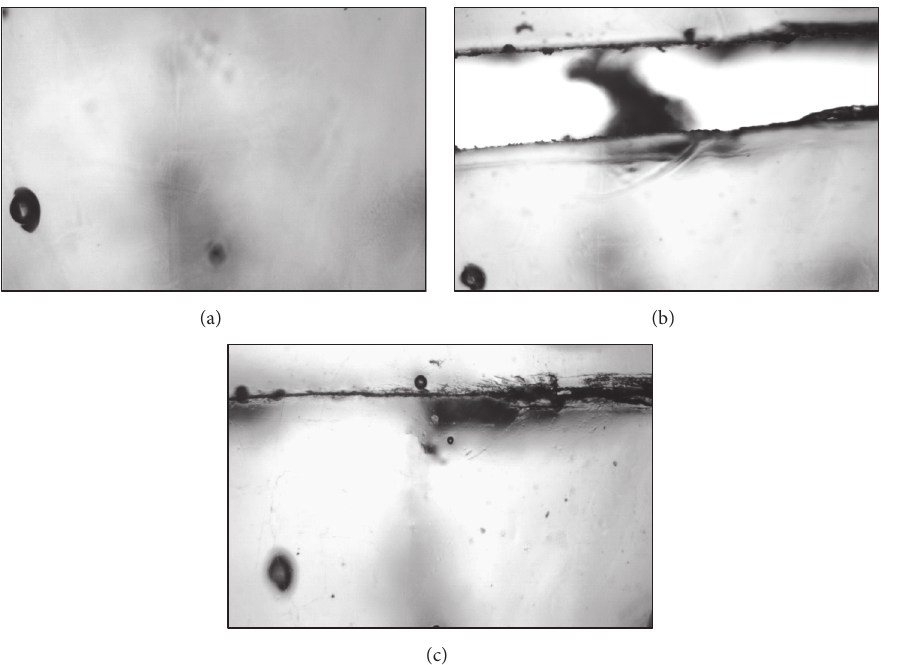
Figure 6: Photographs of the epoxy test specimen with 40 mol% of thiol-ene system: (a) before the cut, (b) after the cut, and (c) after healing. The healing was carried out at 70 ∘ C.